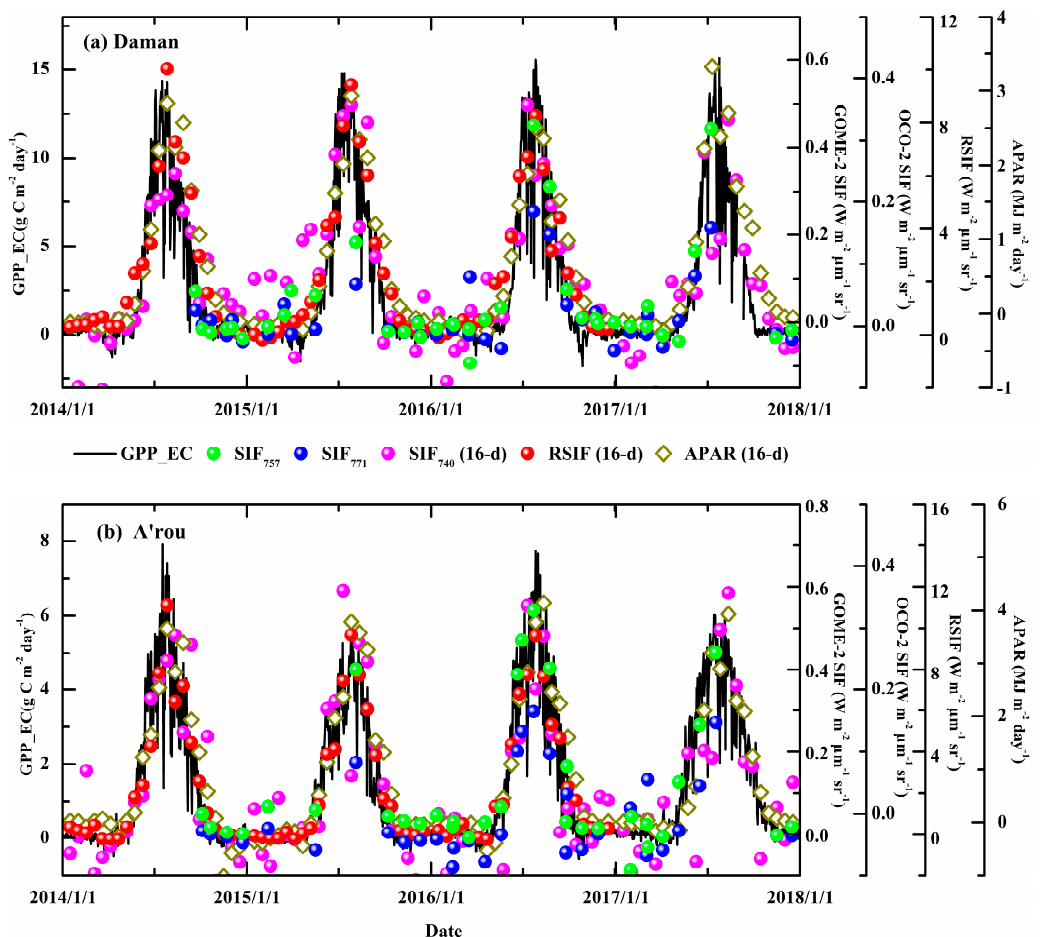
Figure 2. Seasonal cycles of SIF 757 , SIF 771 , SIF 740 (16-d), RSIF (16-d), APAR (16-d), and tower GPP for the period 2014–2017 at the (a) Daman and (b) A’rou sites.